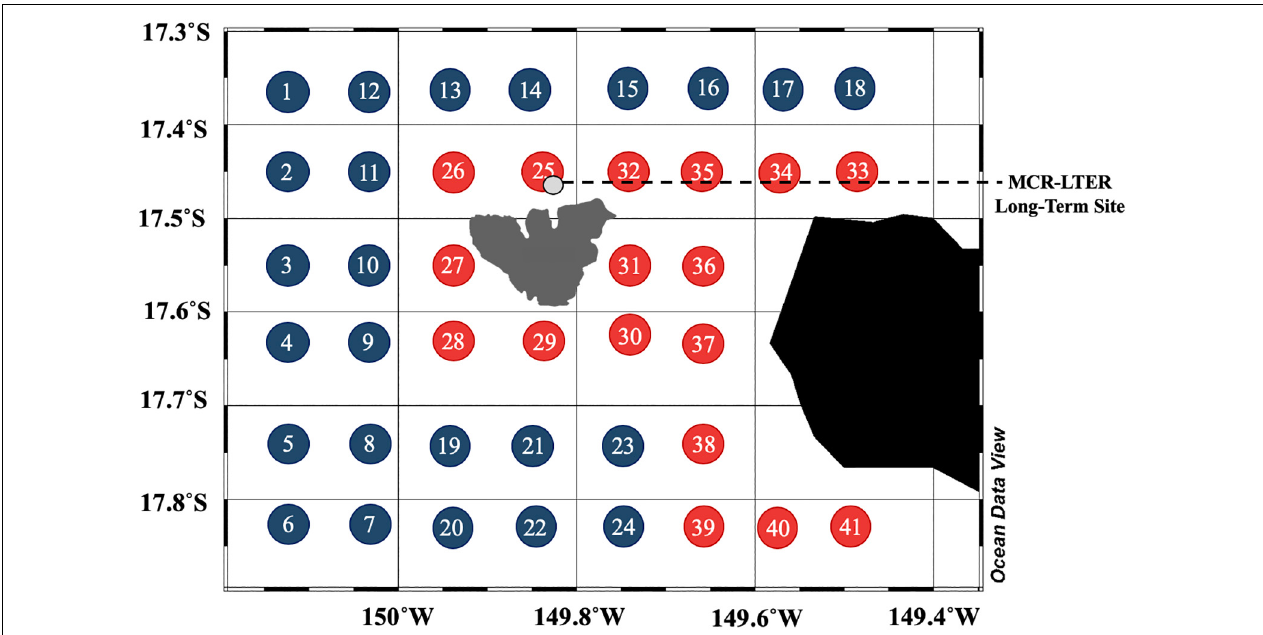
FIGURE 1 | Map of study area around Mo’orea and shipboard sampling grid during July/August 2014. Station numbers and colors refer to offshore stations (blue) and those near Mo’orea and Tahiti (red). Gray point encircled in black is located approximately 5 km offshore of the reef crest and indicates the MCR-LTER long-term collection site